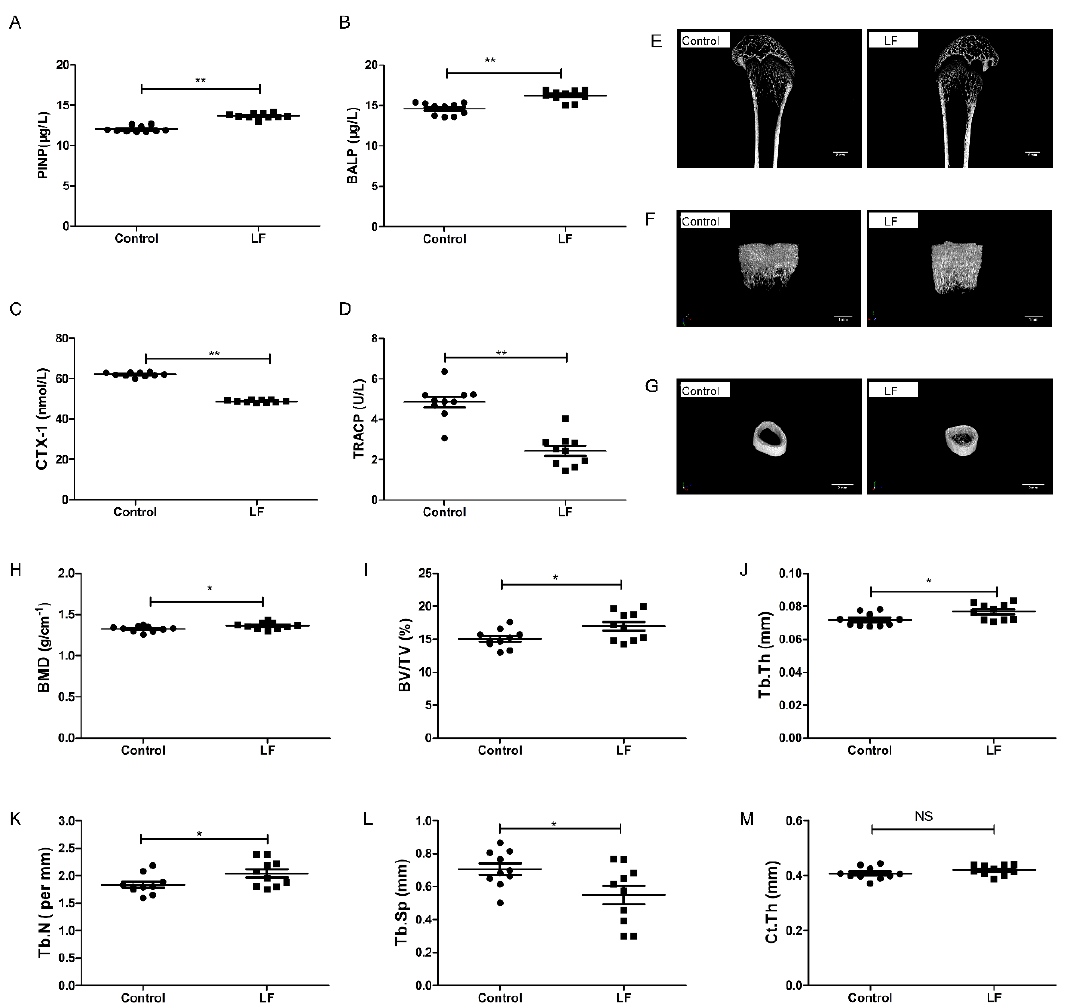
Figure 1. LF supplementation enhanced bone formation, reduced bone resorption, and induced bone mass microarchitecture. Growing SD rats were divided into the control group without LF supplementation and the lactoferrin group LF-supplemented (1000 mg / kg bw). ( A ) E ff ect of LF on the rat serum marker of bone formation, PINP. ( B ) E ff ect of LF on the rat serum marker of bone formation, BALP. ( C ) E ff ect of LF on the rat serum marker of bone resorption, CTX-1. ( D ) E ff ect of LF on the rat serum marker of bone resorption, TRACP. ( E ) Representative µ -CT images of proximal femur (scale bar = 2 mm). ( F ) Representative three-dimensional reconstructions µ -CT images of femoral trabeculae (scale bar = 1 mm). ( G ) Representative three-dimensional reconstructions µ -CT images of femoral cortex (scale bar = 2 mm). ( H ) Bone mineral density (BMD, g cm − 2 ). ( I ) Bone volume / tissue volume (BV / TV, %). ( J ) Trabecular thickness (Tb.Th, mm). ( K ) Trabecular number (Tb.N, mm − 1 ). ( L ) Trabecular separation / spacing (Tb.Sp, mm). ( M ) Cortical thickness (Ct.Th, mm). Data represent means ± SEM (* p < 0.05, ** p < 0.01, n = 10 per group). The control and lactoferrin groups